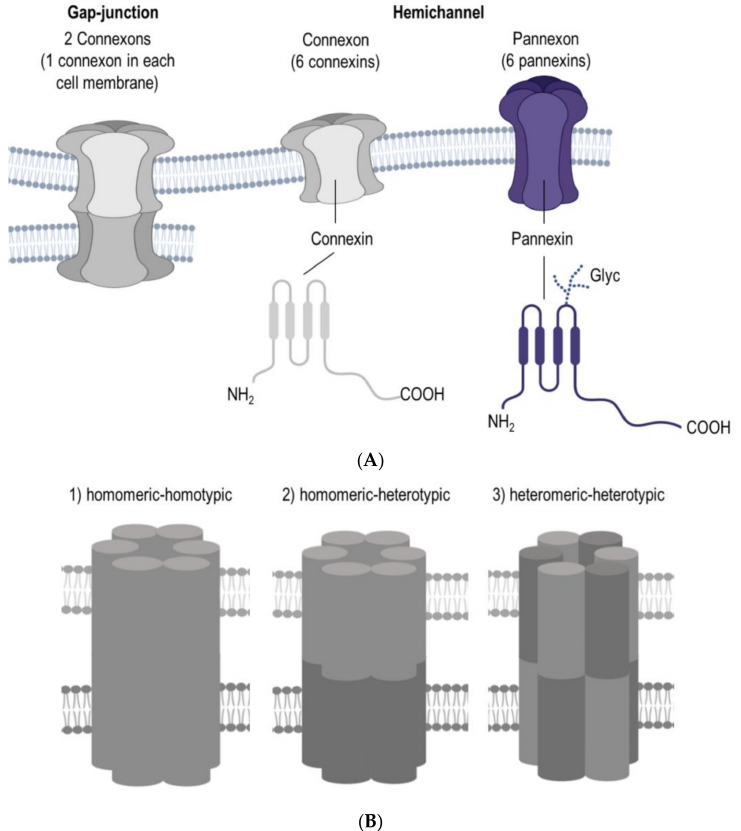
Figure 1. ( A ) Connexin and pannexin share a similar structure, despite the absence of sequence homology. Connexin and pannexin form functional connexon and pannexon hemichannels, re- spectively. Connexins and pannexins are transmembrane proteins with four transmembrane do- mains, two extracellular loops, one cytoplasmic loop, and cytoplasmic N- and C-terminal domains. Connexin channels can assemble into a gap junction that mediates intercellular communication, while pannexin’s extracellular loop can have different degrees of glycosylation in mammalian cells, which prevent the formation of gap junctions, three variants of glycosylation are known: GLY0, GLY1, and GLY2. ( B ) The permeability properties of gap junction channels depend on their con- nexin composition: channels can be (1) homomeric-homotypic, (2) homomeric-heterotypic, or (3) heteromeric-heterotypic. Abbreviation: Glyc =